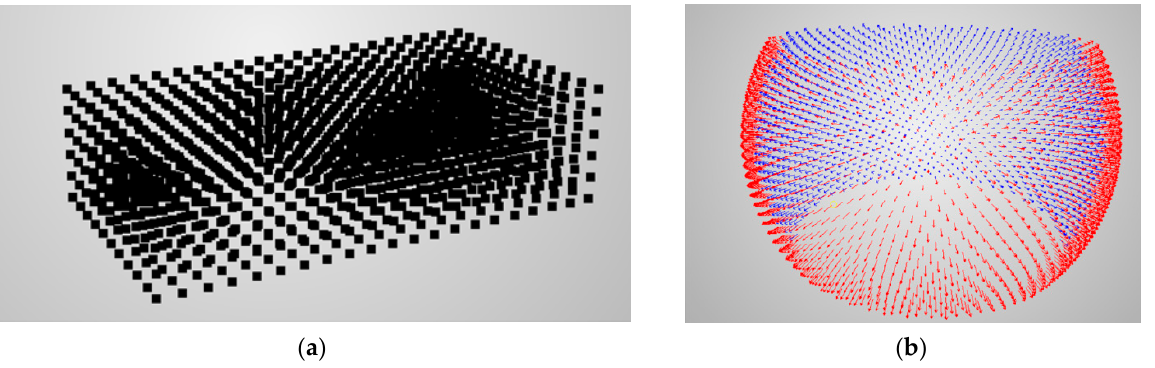
Figure 6. Example of ( a ) discretised measurement volume and ( b ) normal directions of single points for calculating predictions.